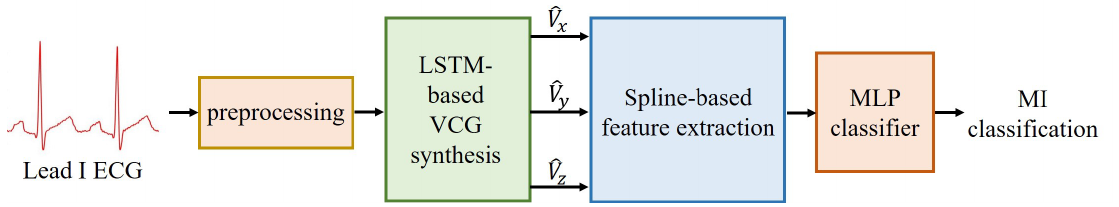
Figure 2. Block diagram of the proposed MI classification